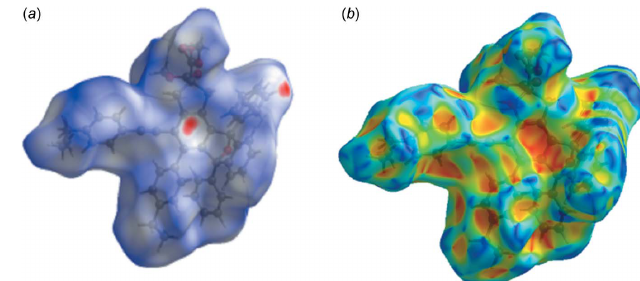
Figure 3 ( a ) The Hirshfeld surface mapped over d norm in the range (cid:5) 0.260 (red) to